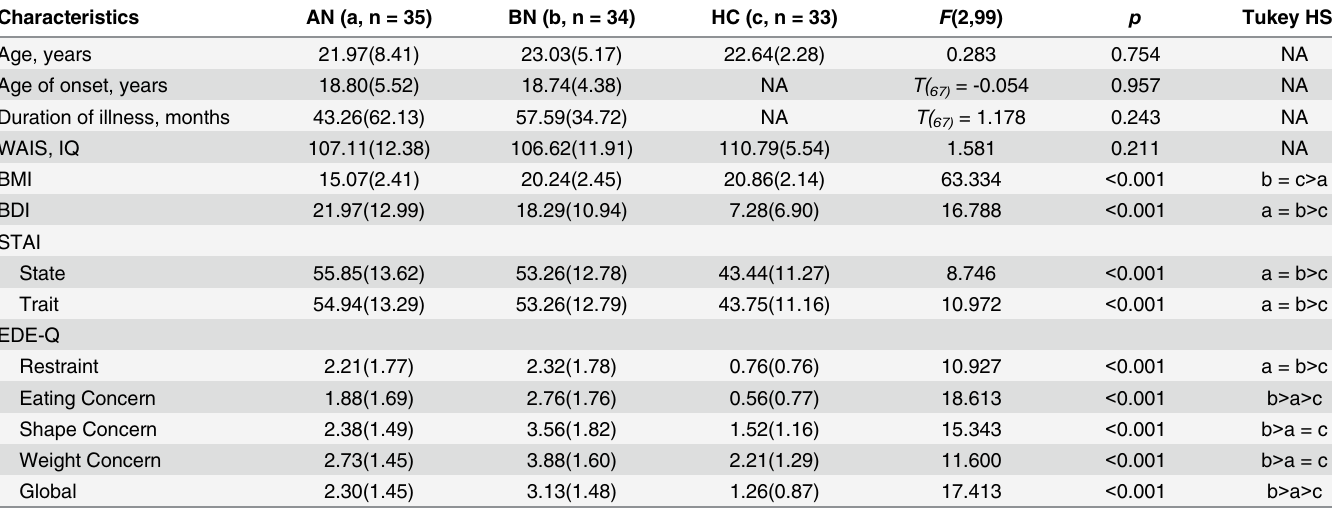
Table 1. Demographic and clinical characteristics of healthy controls and the patients with anorexia nervosa and bulimia nervosa.